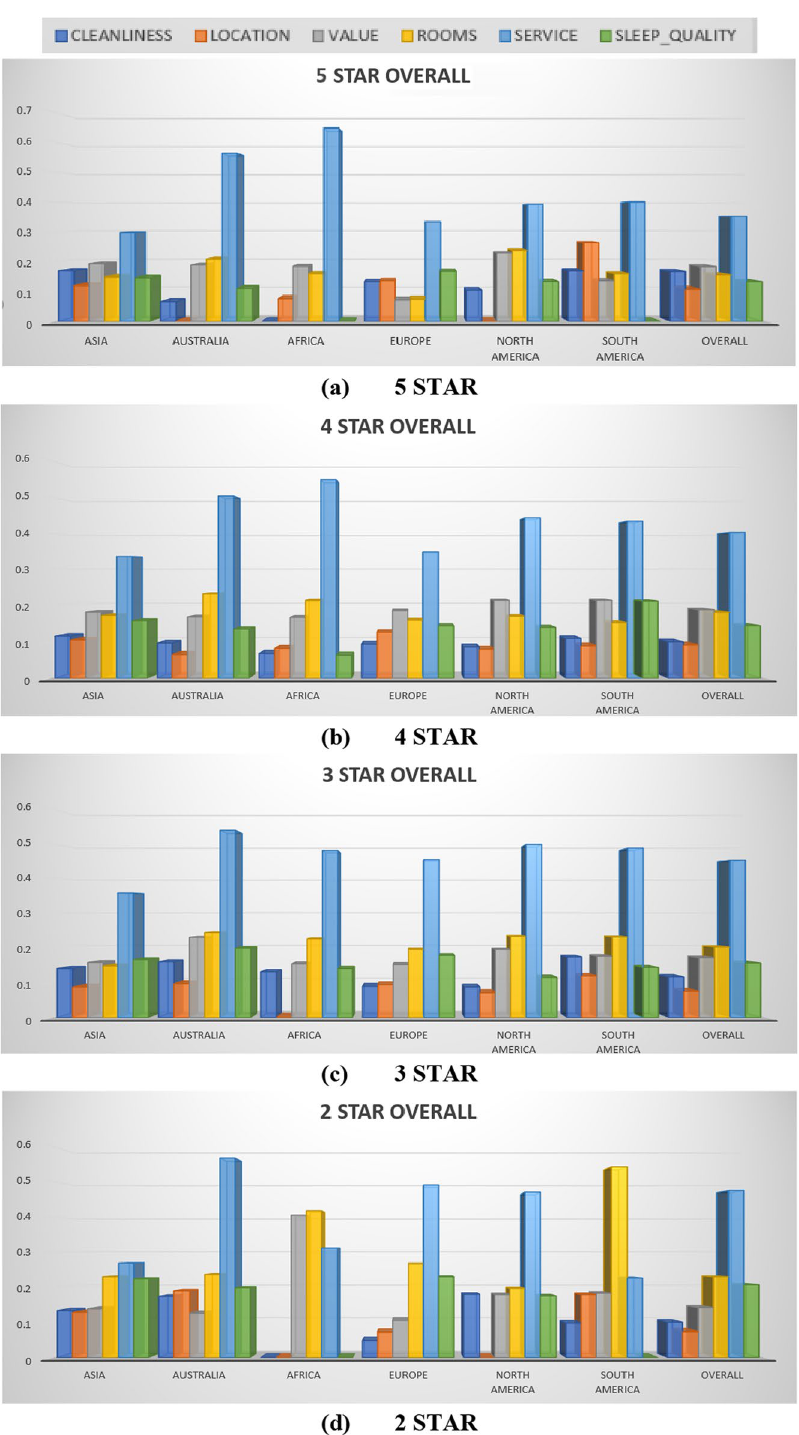
Fig. 2 Graphical illustration offor each hotel class upon overall rating on continent. a 5 STAR, b 4 STAR, c 3 STAR, d 2